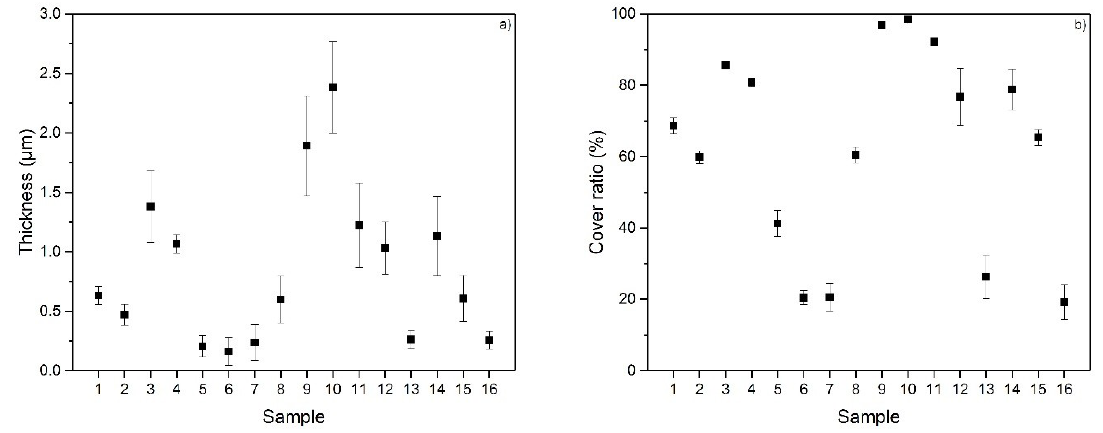
Figure 1. Average thickness ( a ) and cover ratio ( b ) of the FSs (N = 4 and SD).